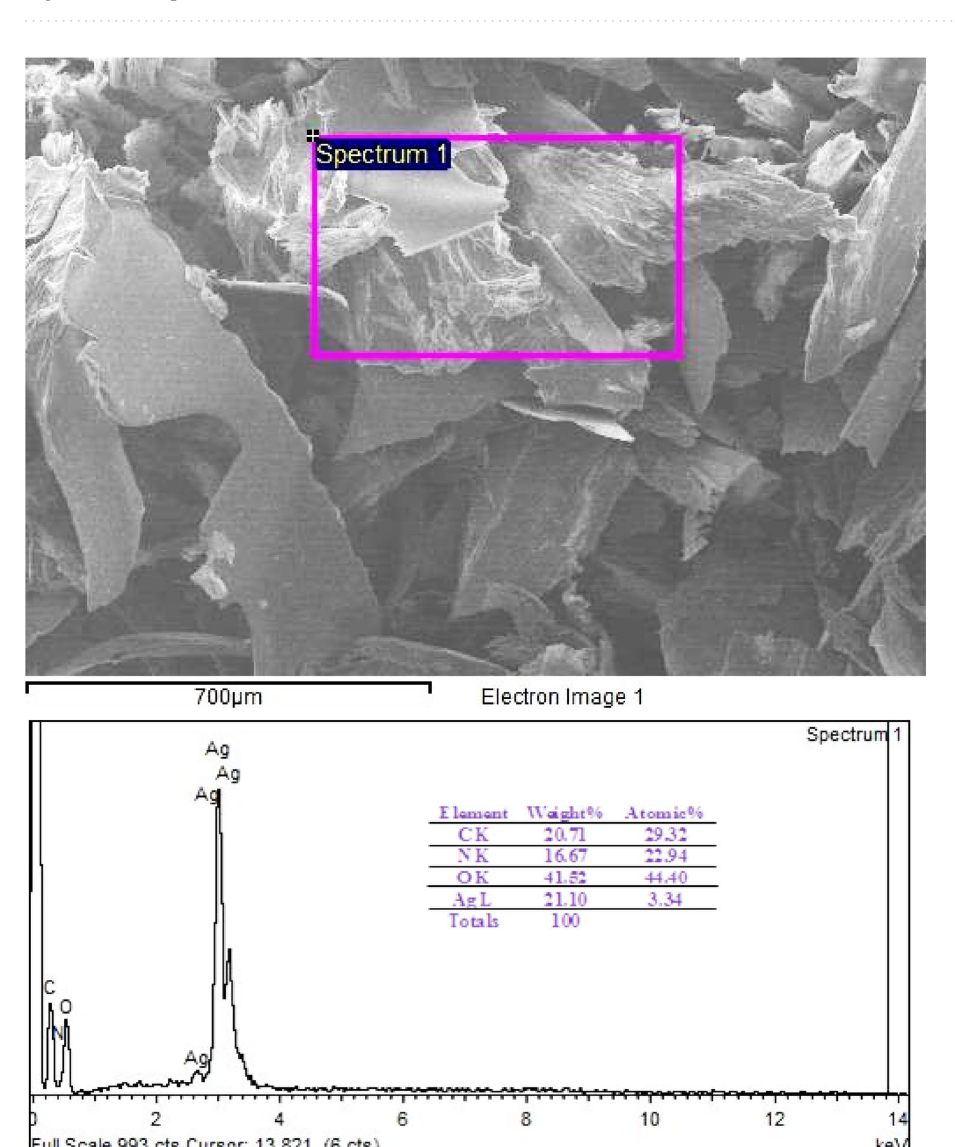
Figure 7. EDX of the prepared chitosan-based Ag NPs stabilized in